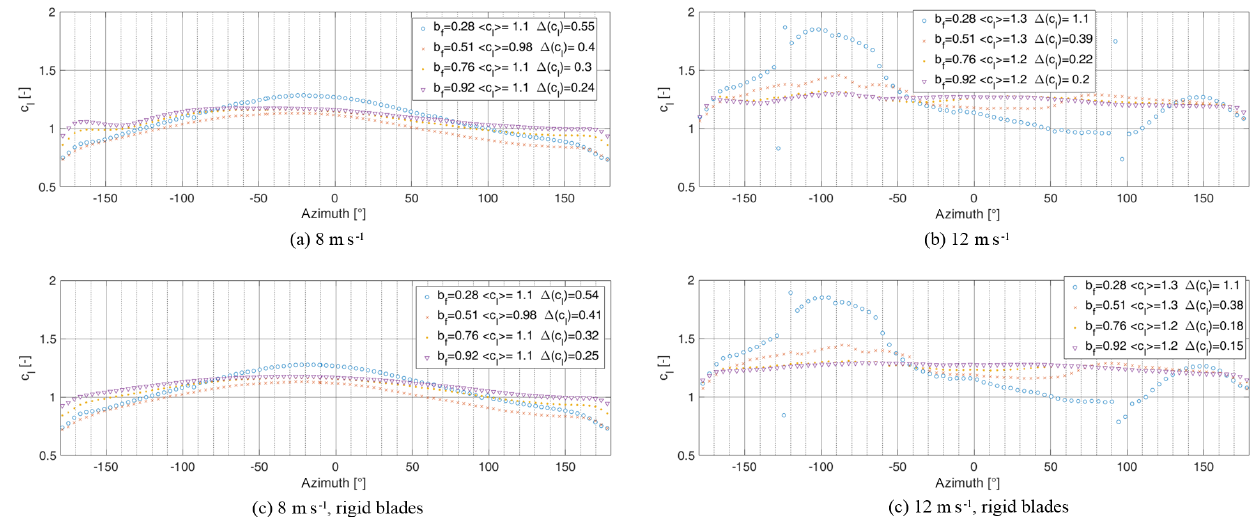
Figure 8. FASTv8 results with steady winds; (a) c l vs. ψ for 8ms − 1 wind speed and 12.5 ◦ yaw offset, (b) as in (a) for a hub-height wind speed of 12ms − 1 , and (c, d) as in (a, b) but with rigid blades and tower. Note that the legends provide mean (denoted by <> ) and range (max–min) of c l for the various span stations ( b f ).